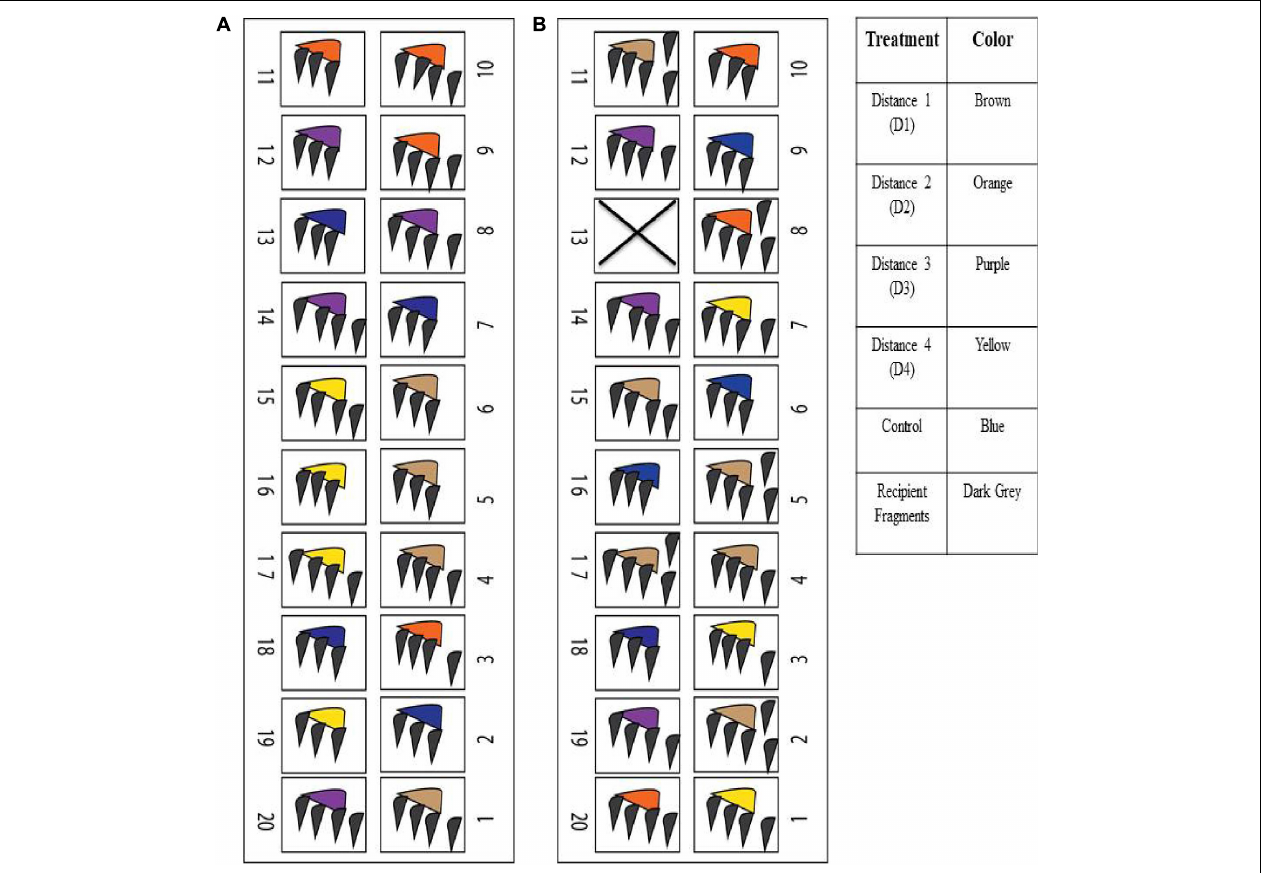
FIGURE 3 | The experimental design matrices of the aquaria set ups for the two induction experiments. (A) M. cavernosa – M. cavernosa experiment, (B) M. cavernosa – O. faveolata experiment.